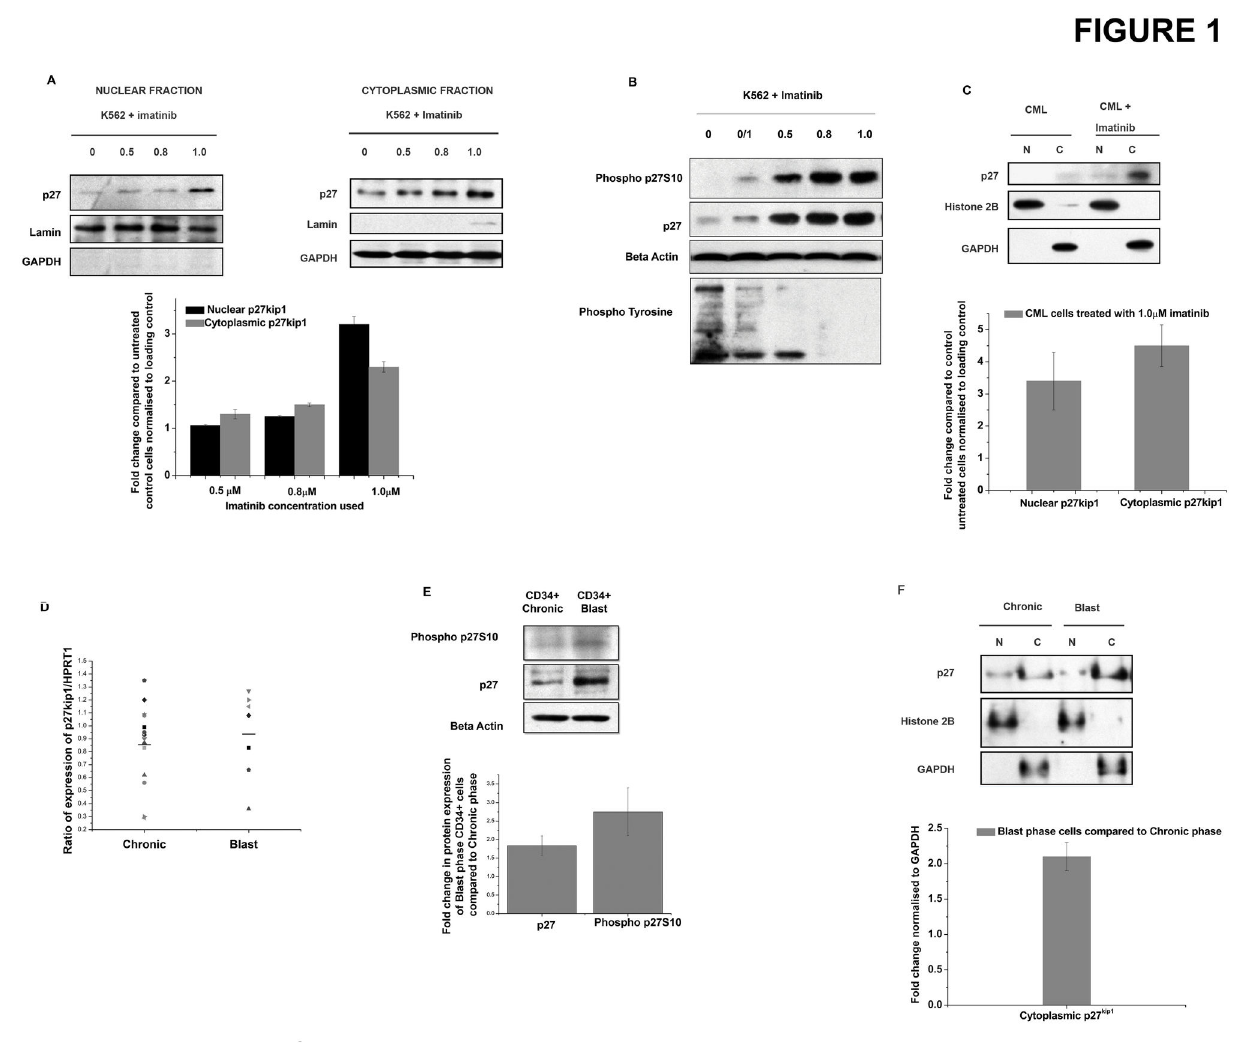
Figure 1. Cytoplasmic p27 kip1 is dependent on p210 Bcr-Abl . (A) K562 cells treated with the indicated doses (in µM) of imatinib for 24hrs were subjected to sub-cellular fractionation and the nuclear and cytoplasmic fractions were used to detect the levels of p27 kip1 . Lamin and GAPDH were used as loading controls for nuclear and cytoplasmic fractions respectively. Densitometric analysis indicates the mean ± s.e.m of three independent experiments with p<0.007 (B) K562 cells were treated with imatinib with the indicated dose (in µM) for 24 hr and the levels of phosphorylated p27 kip1 S10 and p27 kip1 was assessed by western blotting. Beta actin was used as a loading control. (C) Primary chronic phase CML cells were treated with/without imatinib and then subjected to nuclear and cytoplasmic fractionation. The fractions were used to detect the levels of p27 kip1 . Histone 2B and GAPDH were used as loading controls for nuclear and cytoplasmic fractions respectively. The panel shows a densitometric analysis of three independent experiments with mean±s.e.m (p<0.01). (D) mRNA expression of p27 kip1 in chronic and blast phase CD34 + stem and progenitor cells of CML was assessed by qRT-PCR. The expression was normalised against HPRT1. Horizontal bar indicates the mean of expression for the individual phase. (E) Protein expression of p27 kip1 S10 and p27 kip1 in chronic and blast phase CD34 + cells. Beta actin was used as a loading control. Densitometric analysis of the blots shows the mean ± s.e.m of 4 individual experiments (p<0.02). (F) Primary chronic and blast phase CML cells were subjected to nuclear and cytoplasmic fractionation. The fractions were used to detect the levels of p27 kip1 . Histone 2B and GAPDH were used as loading controls for nuclear and cytoplasmic fractions respectively. The panel shows a representative blot of two independent experiments. Densitometric analysis of two independent experiments has been shown with mean±s.e.m . Lower panel shows the fold change in expression of p27 kip1 in the cytoplasm of Blast phase CML cells compared to Chronic phase CML cells. doi: